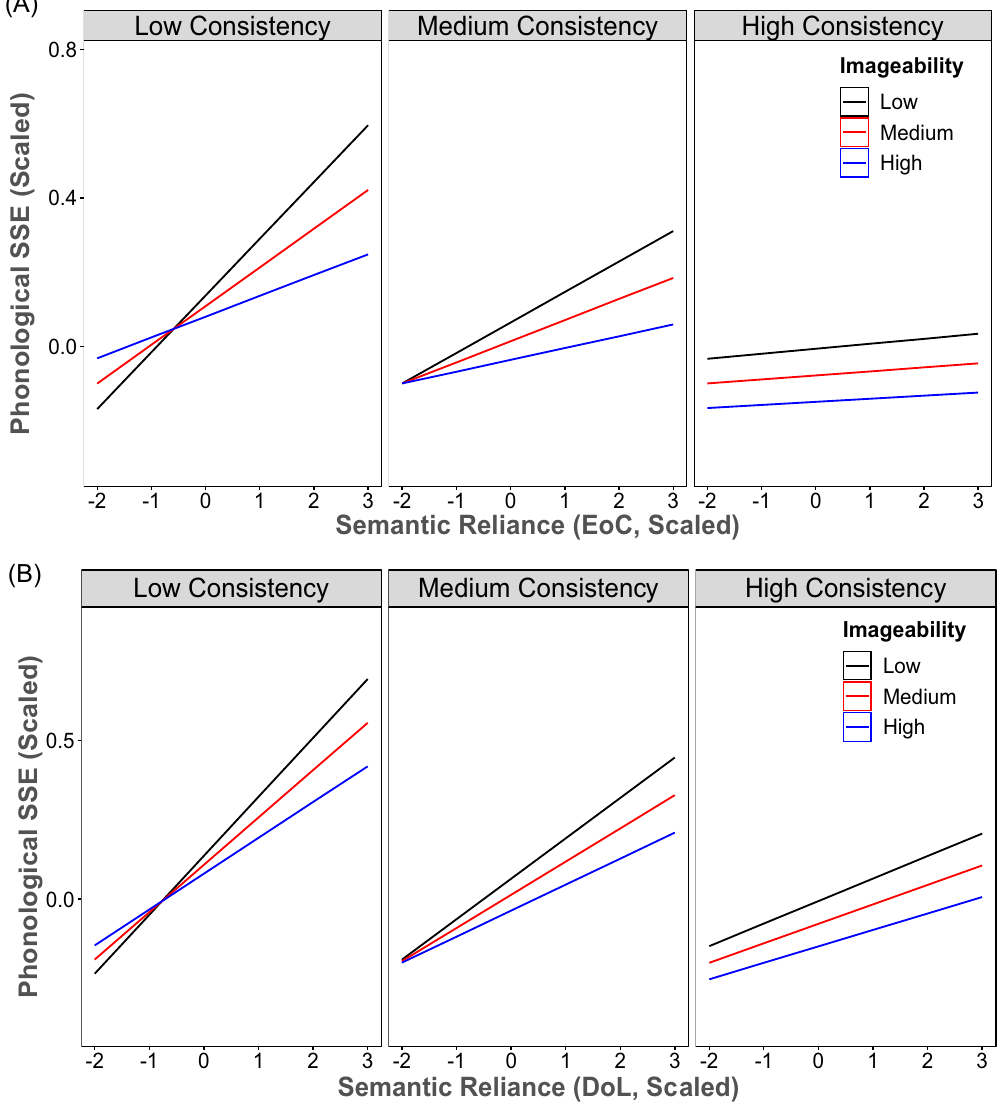
Figure 3. The three-way interaction between EoCSR ( A ) or DoLSR ( B ), imageability, and consistency in the reading aloud task. EoCSR: semantic reliance based on the effect of consistency; DoLSR: semantic reliance based on the division of